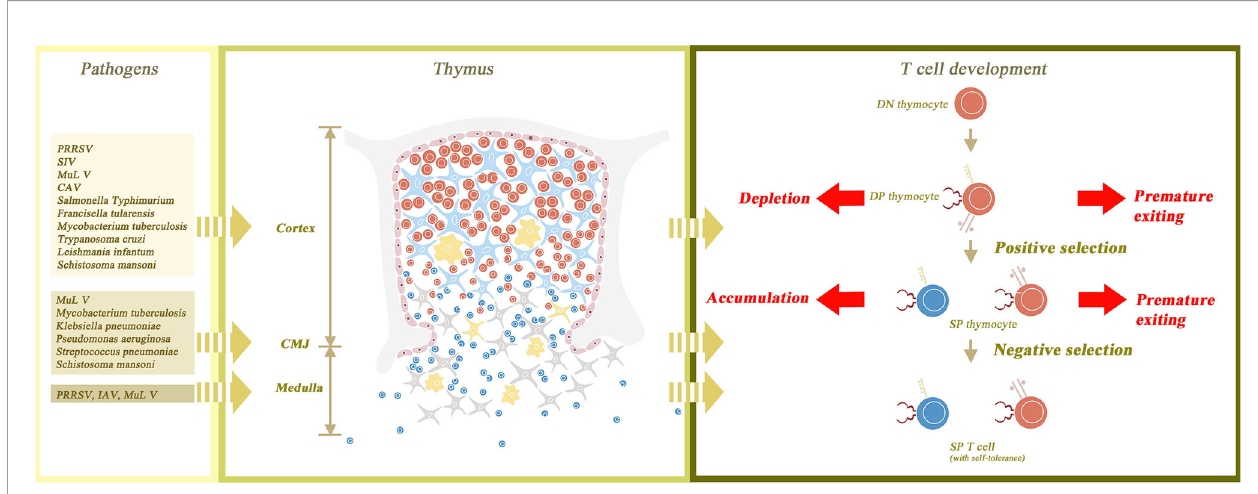
FIGURE 1 | The normal structure of the thymus gland and the changes that occur with atrophy. The thymus parenchyma is composed of cortex and medulla, which are separated by cortico-medullary junction (CMJ). The cortex is constructed from thymic epithelial cells (TEC) as its framework and thymocytes fi lling in the interspace. The medulla is composed of TECs, naïve T cells and macrophages. The process of T cell maturation begins with the transformation of double negative (DN) thymocytes to double positive (DP) thymocytes in the outer cortex of the thymus gland. DP thymocytes then undergo positive and negative selection in the inner cortex and medulla, respectively, to become self-tolerant single positive (SP) thymocytes. Finally, SP thymocytes mature and are transported to peripheral lymphoid tissues. Thymic atrophy leads to the destruction of thymus structure and abnormal maturation of thymocytes. In thymic atrophy, the medullary structure is destroyed and the CMJ is disappeared, so both positive and negative selection are interrupted. Without positive selection, premature exiting of DP thymocytes may occur. Without negative selection, the autoreactive T cells may have the opportunity to migrate out of the thymus. In addition, cortical structural disorders not only cause the depletion of a large number of DP thymocytes, but also delay the maturation of SP thymocytes, leading to the accumulation of SP thymocytes. Besides, the fi gure also shows the main affected sites of thymus corresponding to different